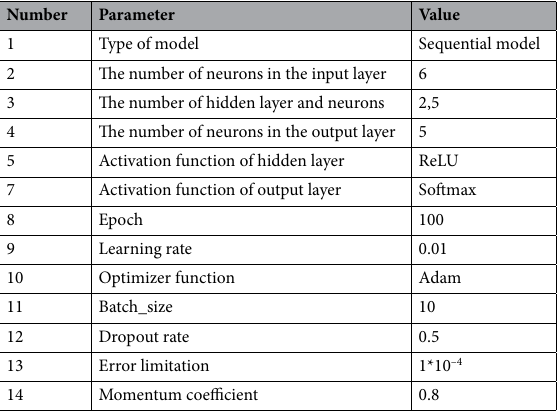
Table 1. The hyperparameters of the intelligent evaluation of the ANN model.